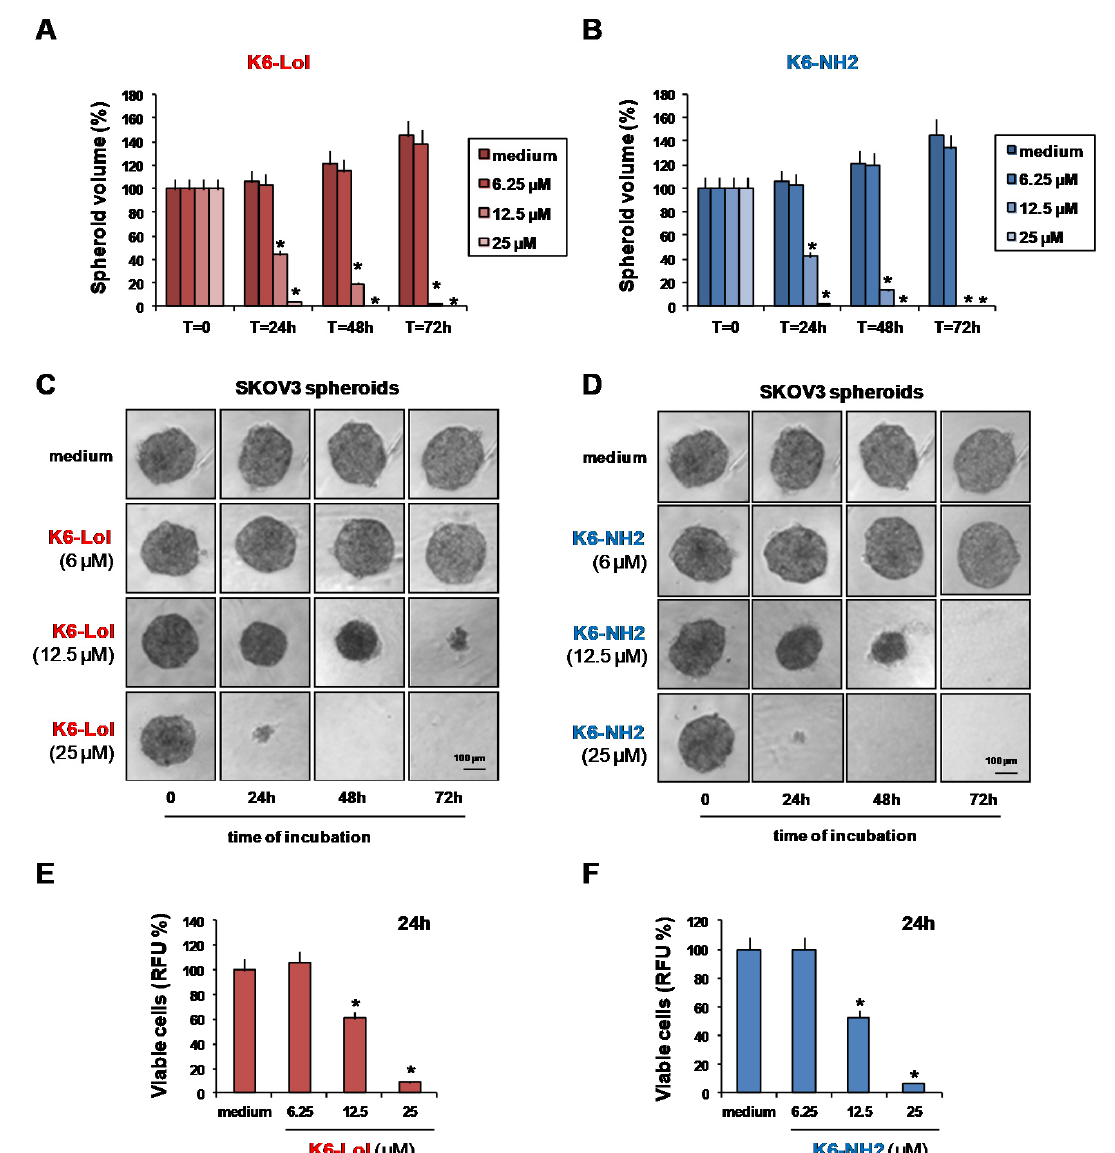
Figure 3. K6-Lol and K6-NH2 activity in SKOV3 spheroids (3D model). Four-day old SKOV3 single pre-formed spheroids were cultured in the absence or in the presence of ( A ) K6-Lol and ( B ) K6-NH2. Responses were evaluated by spheroid volume measurements. Values in the bar graphs are the mean and SD of the volume of at least five spheroids and three independent experiments. * p < 0.05 vs. medium. ( C , D ) Representative phase contrast micro-photographs showing SKOV3 spheroid volume decrease by ( C ) K6-Lol and ( D ) K6-NH2 treatment (original magnification 4 × ). ( E , F ) SKOV3 spheroid cell viability after 24 h treatment evaluated using PrestoBlue Cell Viability Reagent. Values are means and SD of three experiments each run in triplicate. * p < 0.05 vs. medium.